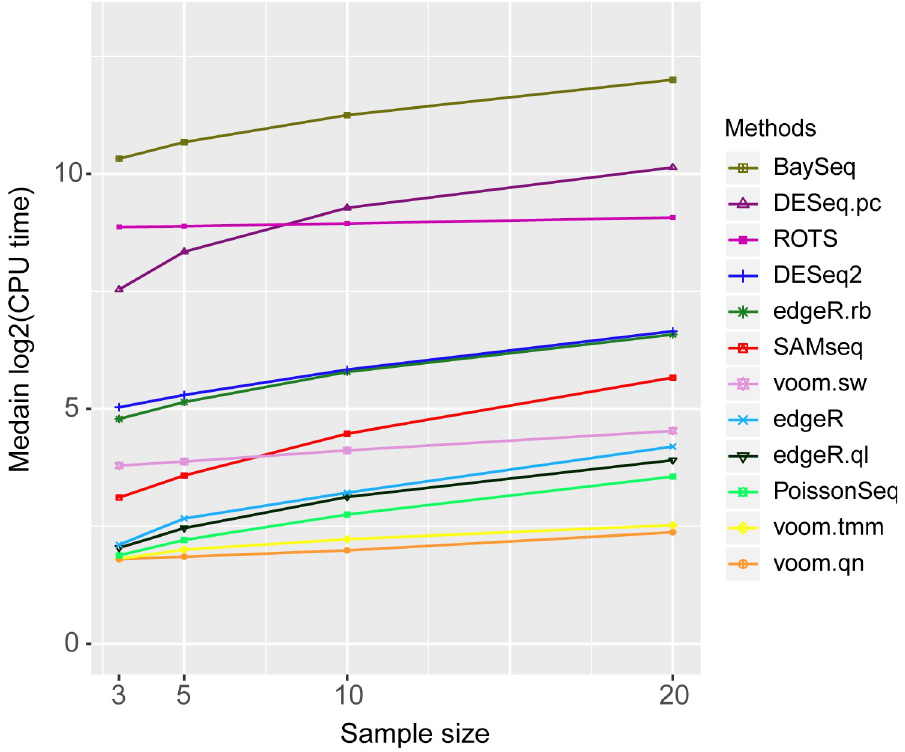
Fig 5. CPU-times to run DE analysis methods for KIRC data. Each method was run 10 times for different sample sizes 3, 5, 10, and 20.